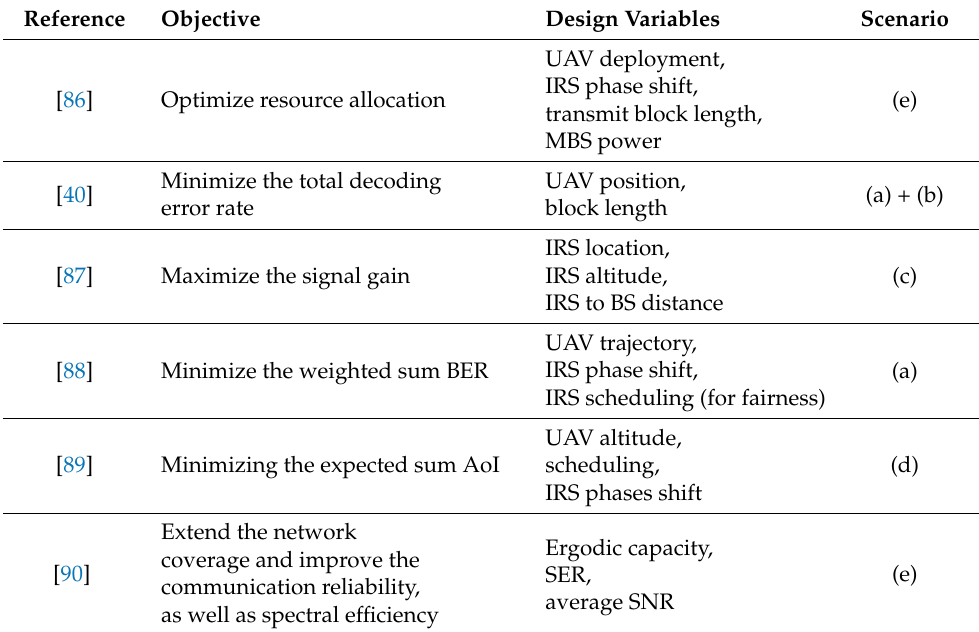
Table 4. Summary of previous works relevant to improvement of other